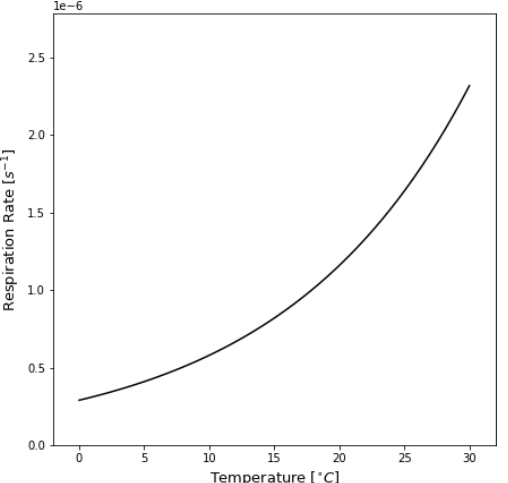
Figure F1. The algal rate of respiration [s − 1 ] relative to the temperature of seawater [ ◦ C] as defined in Kooi et al. (2017) and in Eq. (8) in this study. Colder temperatures cause lower respiration rates, and increasing the temperature exponentially increases the respiration rate. Since respiration is the dominant term below the MLD for almost all trajectories (Fig. 6), it defines the oscillatory behaviour of the